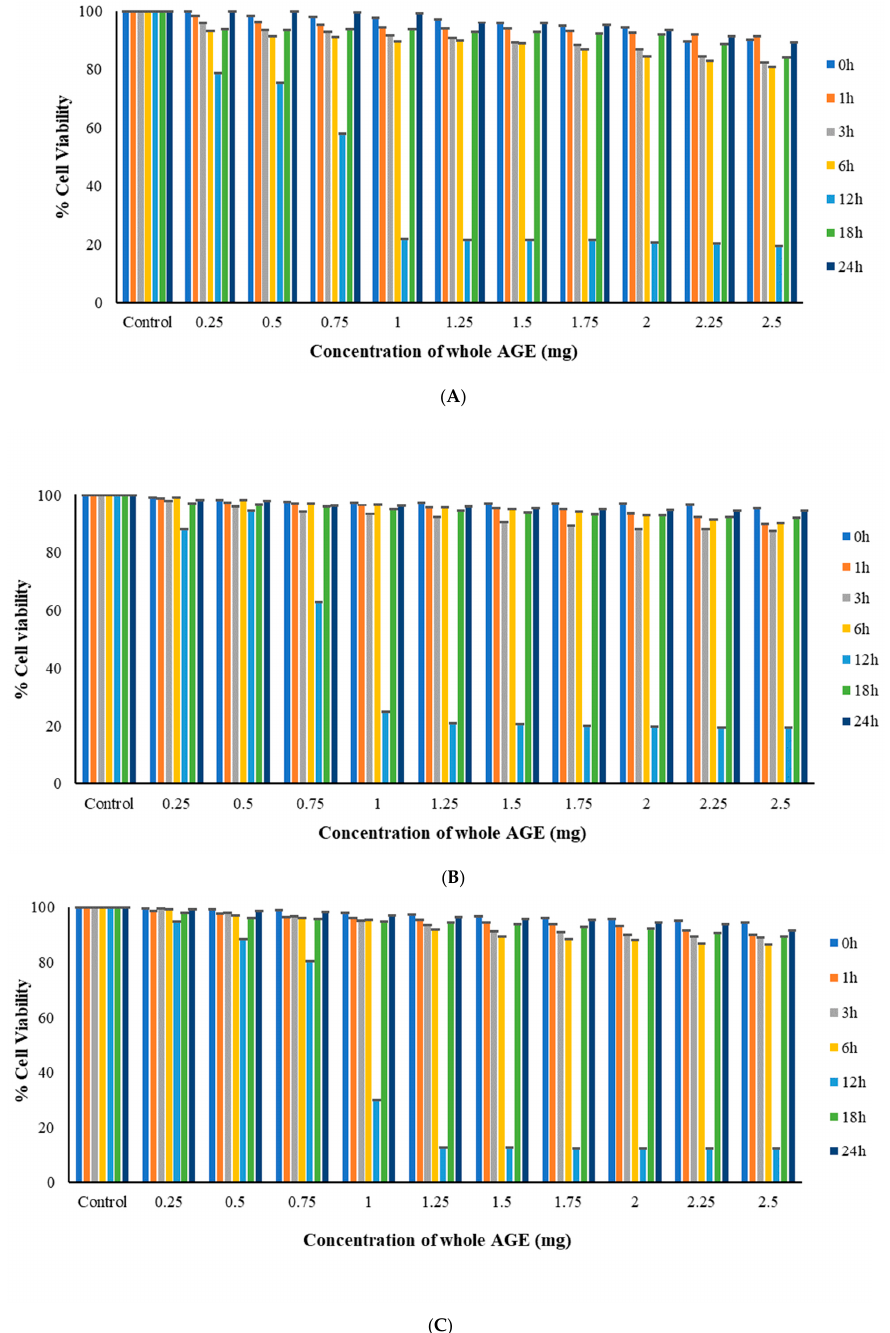
Figure 3. ( A ) MTT Assay to confirm the antimicrobial activity of whole AGE against C. albicans M207 at different time intervals. Cell viability of 21.8% was observed at 1.25 mg at 12 h (MIC 50 ) and n = 3. The Assay was performed in triplicate. ( B ) MTT Assay to confirm the antimicrobial activity of whole AGE E. coli ATCC 39936 at different time intervals. Cell viability of 20.97% was observed at 1.25 mg at 12 h (MIC 50 ) and n = 3. The Assay was performed in triplicate. ( C ) MTT Assay to confirm the antimicrobial activity of whole AGE against C. albicans M207+ E. coli ATCC 39936 at different time intervals. Cell viability of 13.06% was observed at 1.25 mg at 12 h (MIC 50 ) and n = 3. All values are expressed as mean and standard deviation.